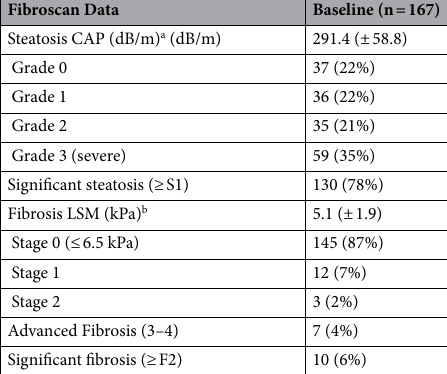
Table 2. Baseline Fibroscan results. Results expressed as mean (± SD) or frequency (percentage). a CAP = Controlled attenuation parameter steatosis grades: 0 (nil significant) < 248 dB/m; 1 (mild) 248– 280 dB/m; 2 (moderate) = 281-319 dB/m; 3 (severe) > 320 dB/m. b LSM = Liver stiffness measurement fibrosis stages: 0 (no significant fibrosis) ≤ 6.5 kPa; 1 (mild) 6.6–8.2 kPa; 2 (significant) > 8.2–9.6 kPa; 3–4 (advanced) > 9.6